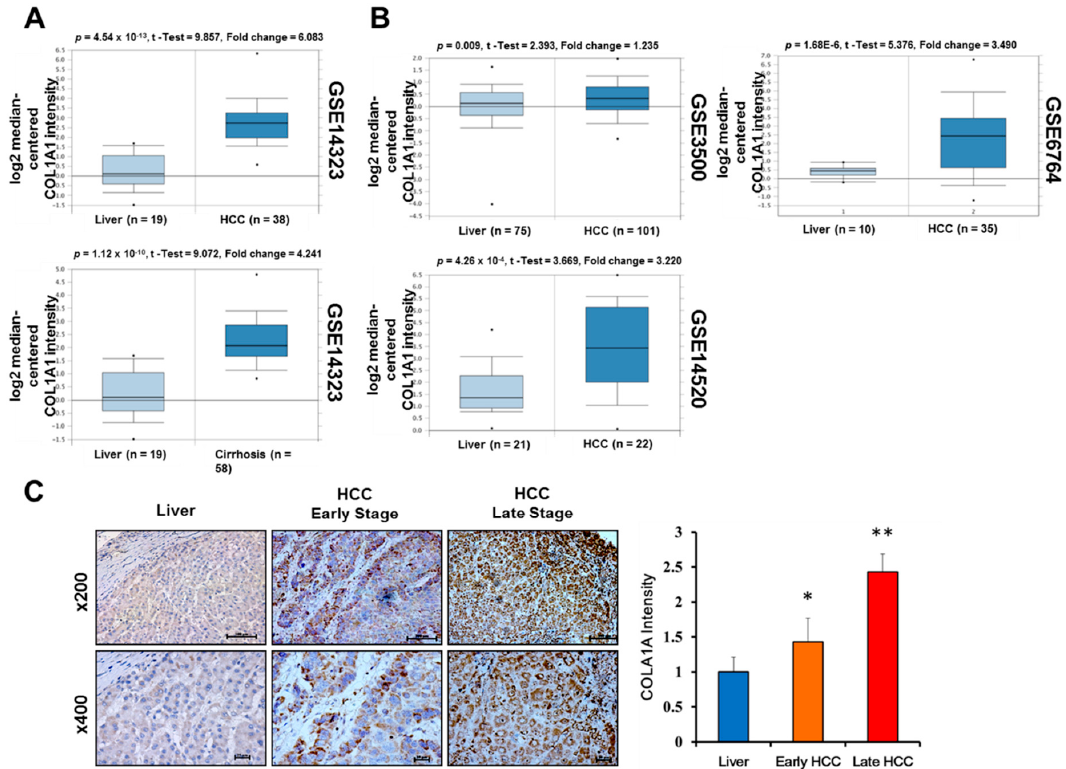
Figure 2. Upregulated COL1A1 expression at both mRNA and protein levels strongly correlates with disease progression. ( A ) Differential expression of COL1A1 in HCC (upper panel) and cirrhosis (lower panel) compared to normal liver samples in the GSE14323 Mas liver dataset. ( B ) COL1A1 is highly expressed in GSE3500 Chen liver, GSE14520 Roessler liver and GSE6764 Wurmbach liver HCC specimens compared to non-tumor liver specimens. ( C ) Representative IHC photo-image (left) and graphical quantification (right) of COL1A1 protein expression in early stage, late stage HCC tissues and adjacent normal tissues. * p < 0.05, ** p < 0.01.